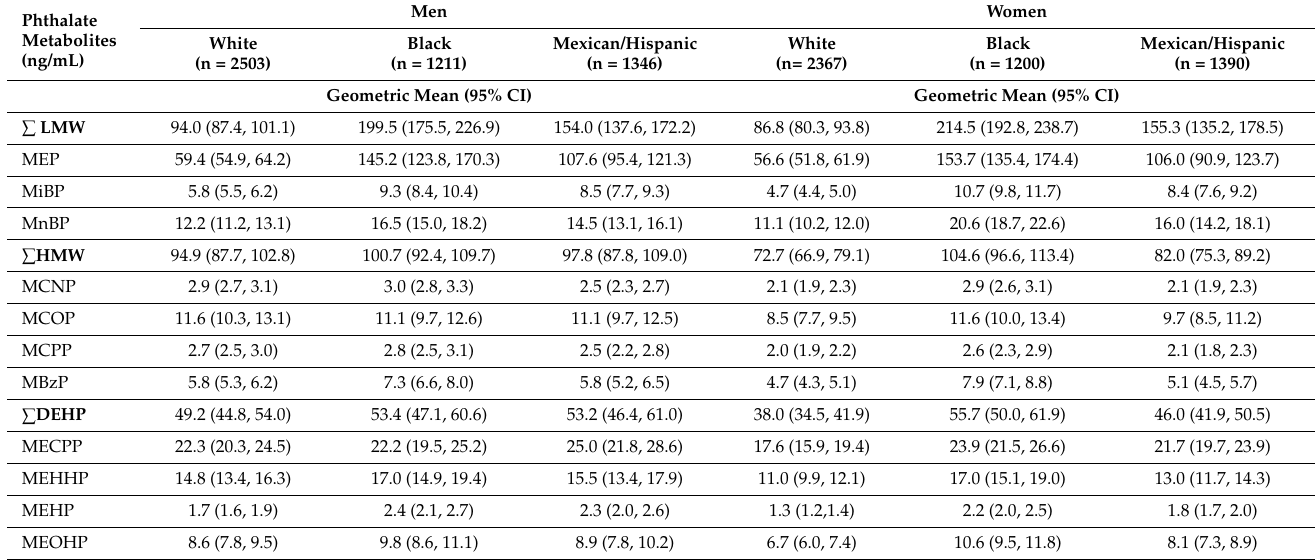
Table 3. Urinary phthalate metabolites among men and women by race, NHANES (2005–2014). Phthalate